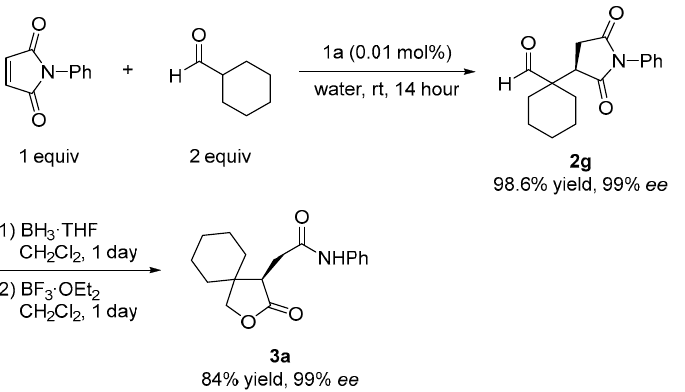
Figure 8. Gram-scale reaction for the application of spironolactone for the Michael reaction of cyclohexanecarboxaldehyde and N -phenylmaleimide.